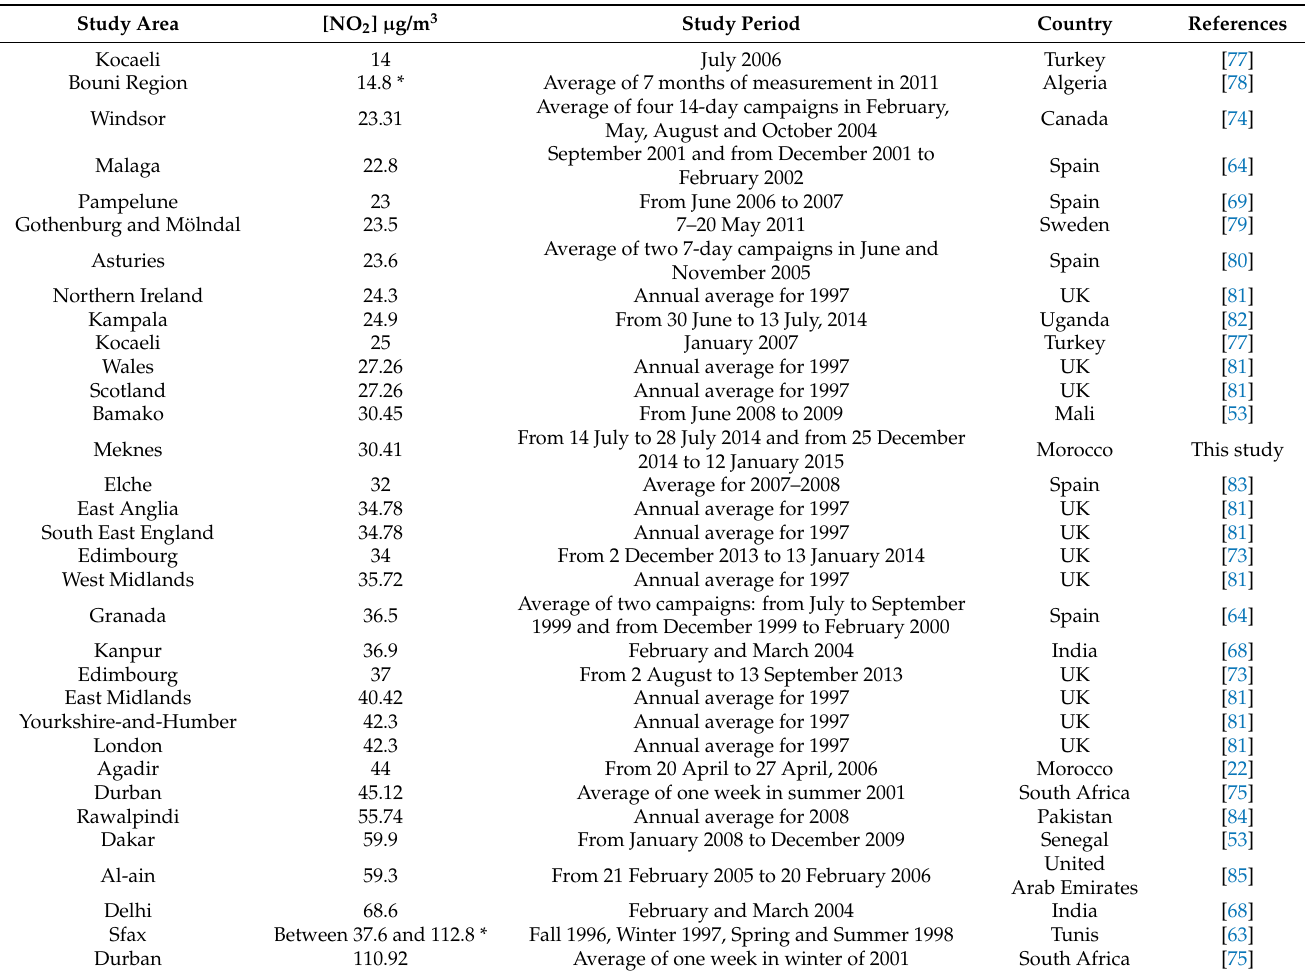
Table 7. NO 2 results were obtained in the city of Meknes compared with other urban agglomera- tions